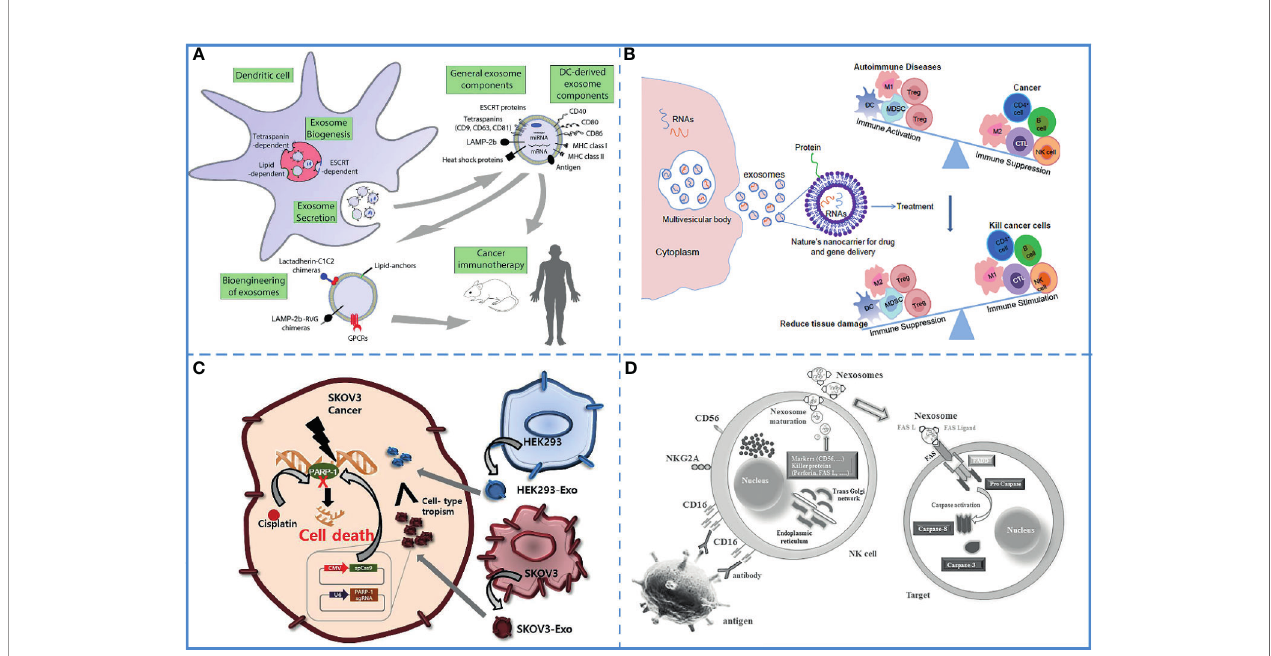
FIGURE 5 | Immunotherapy. (A) DEXs can overcome tumor immunosuppression. Reproduced with permission from ref (150). Copyright 2015 Elsevier. (B) DC- derived exosomes have been used for immunotherapy in animal studies and human clinical trials. It can also be bioengineered to contain speci fi c cargoes. Reproduced with permission from ref (155). Copyright 2014 Elsevier. (C) Compared with epithelial cell-derived exosomes (HEK293-exo), tumor -derived exosomes (SKOV3-Exo) accelerates their accumulation in SKOV3 tumor cells due to their cell tropism. Reproduced with permission from ref (156). Copyright 2017 Elsevier. (D) Nexosomes (NK-derived exosomes) entrap CD markers, perforin, and FAS-L, which mediates cytotoxicity by interacting with FAS on exposed cell membranes. Reproduced with permission from ref (130). Copyright 2017 Wolters Kluwer Health,